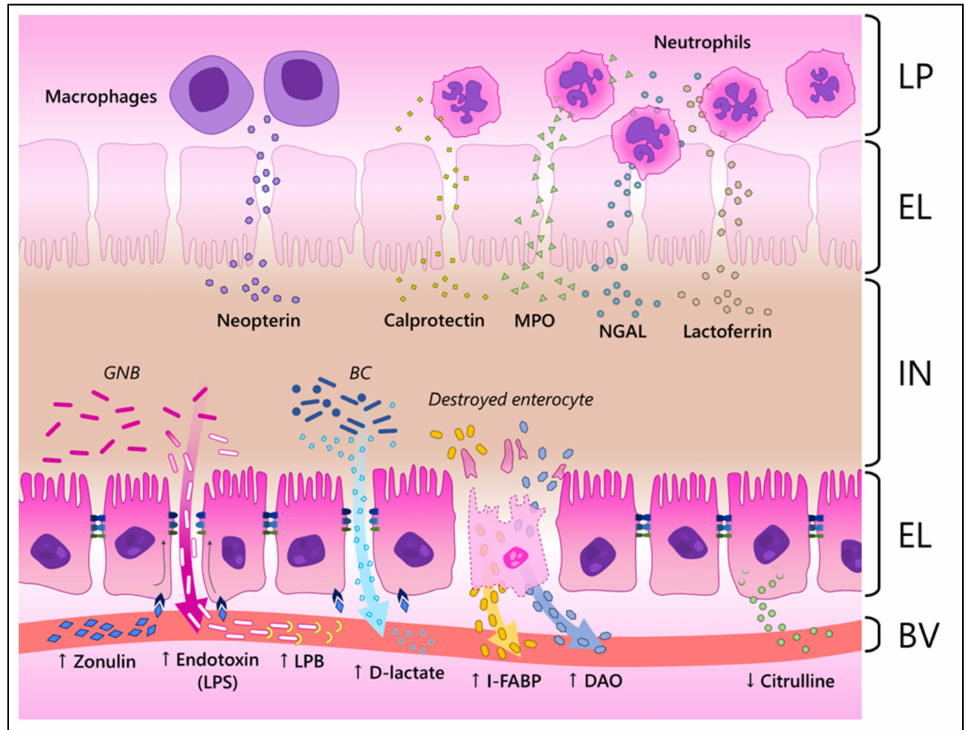
Figure 2. Illustration of how different biomarkers reach the blood and/or the feces during inflamma- tion in the intestinal mucosa. LP, lamina propria; EL, epithelial layer; IN, intestinal lumen; BV, blood vessel; GNB, Gram-negative bacteria; BC, bacterial community; MPO, myeloperoxidase; NGAL, neutrophil-gelatinase associated lipocalin; LPS, lipopolysaccharide; LPB, LPS-binding protein; I-FABP, intestinal fatty acid binding protein; DAO, diamine oxidase. ↑ , increased; ↓ , decreased levels during inflammation. In the illustration, zonulin interacts with its receptors in enterocytes, changing the structure of the tight junctions and, consequently, increasing the paracellular influx. This increased permeability allows bacterial components and metabolites, such as endotoxins and D-lactate, to cross the epithelial barrier and reach the blood stream. Destroyed enterocytes resultant of the inflamma- tory process release their internal components, such as I-FABP and DAO, in the circulatory system. Healthy enterocytes produce citrulline and release it into the blood stream. Therefore, its levels are reduced when enterocytes are damaged. Neutrophils and macrophages that reach the mucosa release antimicrobial components such as neopterin, calprotectin, MPO, NGAL and lactoferrin, which reach the IN. It must be noted that the described biomarkers might reach both the IN and